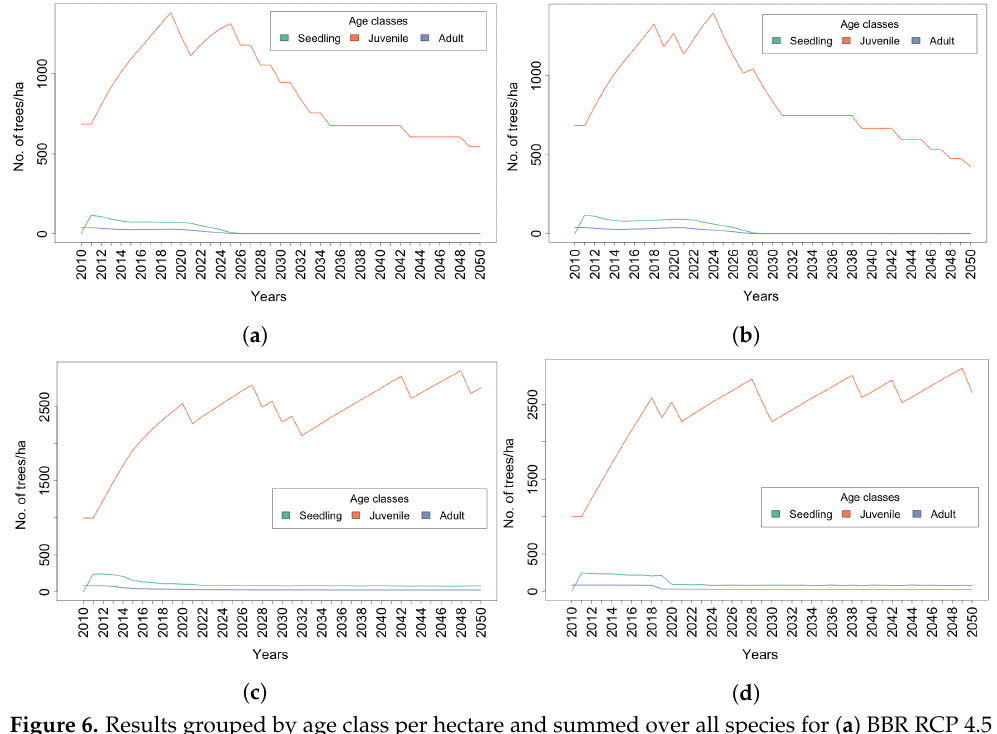
Figure 6. Results grouped by age class per hectare and summed over all species for ( a ) BBR RCP 4.5 Scenario, ( b ) BBR RCP 8.5 Scenario, ( c ) SKU RCP 4.5 Scenario, and ( d ) SKU RCP 8.5